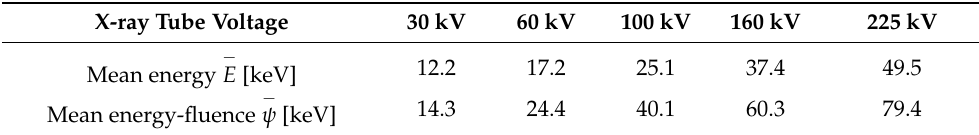
Table 3. Mean energy and energy-fluence of the simulated X-ray beam at different voltages.